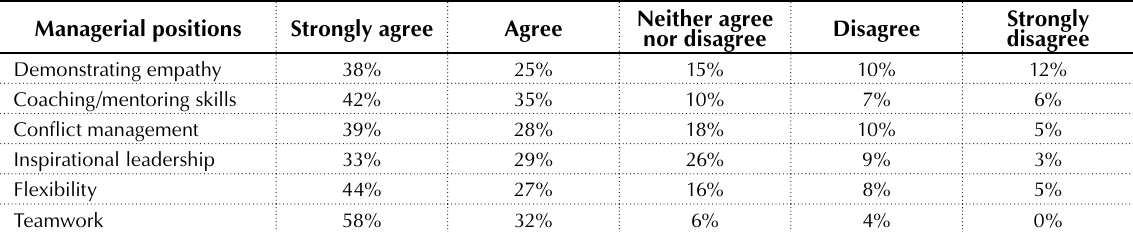
Table 3. Positive attributions of women in managerial positions